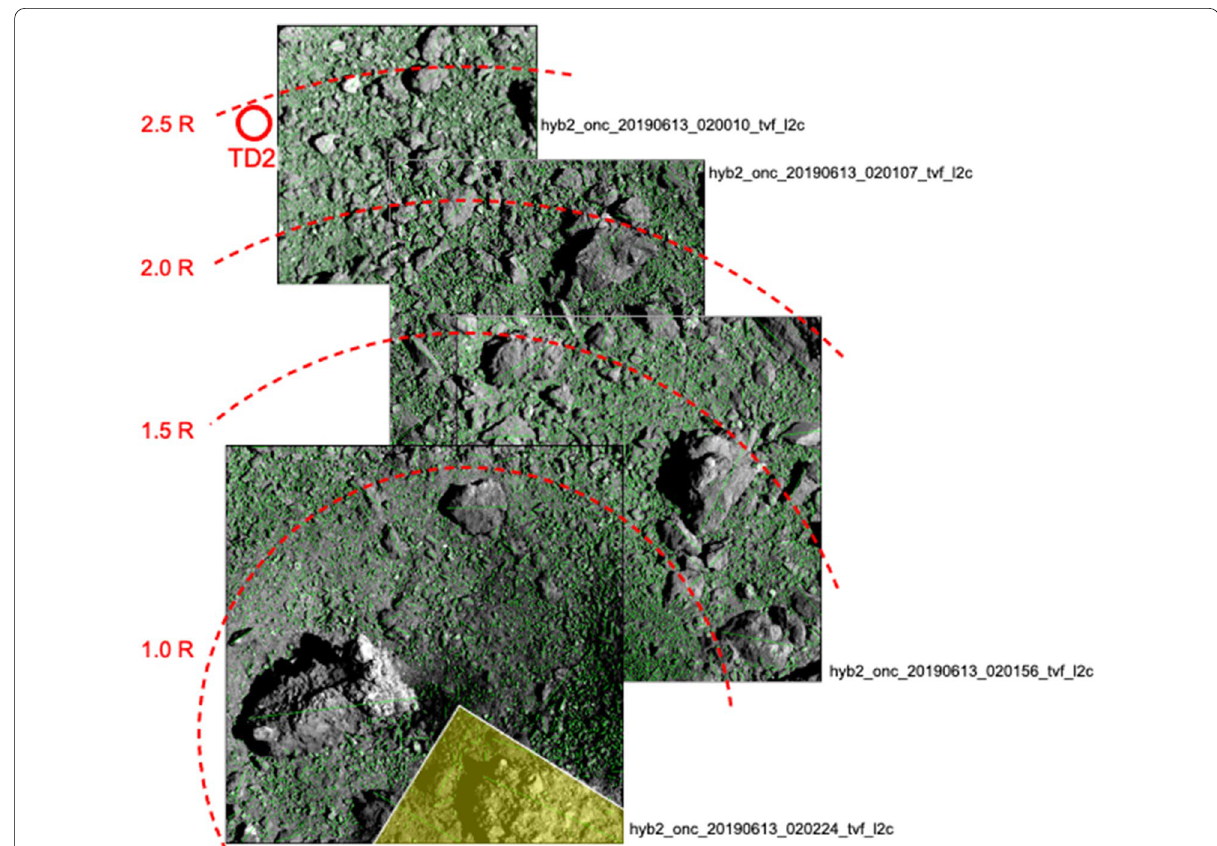
Fig. 1 Analyzed images in this study: hyb2_onc_20190613_020010_tvf_l2c.fit, hyb2_onc_20190613_020107_tvf_l2c.fit, hyb2_ onc_20190613_020156_tvf_l2c.fit, and hyb2_onc_20190613_020224_tvf_l2c.fit, obtained at PPTD-TM1B. The rim of the SCI crater is indicated as a broken semi-circle with a mark of 1.0R. Semi-circles with a label of 1.5R, 2.0R, and 2.5R represent concentric circles centered on the impact point. The yellow-hatched area in the south of the impact point is a forbidden zone at which no cratering process occurred due to the large boulder near the impact point (Arakawa et al. 2020). We did not include the particles in this yellow-hatched area. A red circle labeled “TD2” indicates the location at which the second touchdown and the sampling were